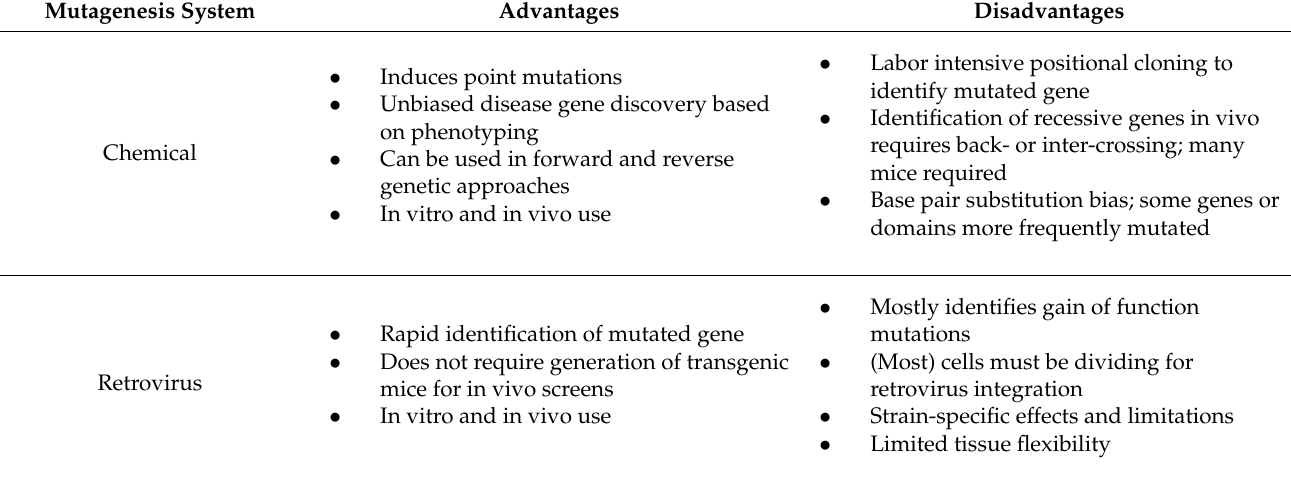
Table 1. The advantages and disadvantages of several mutagenesis